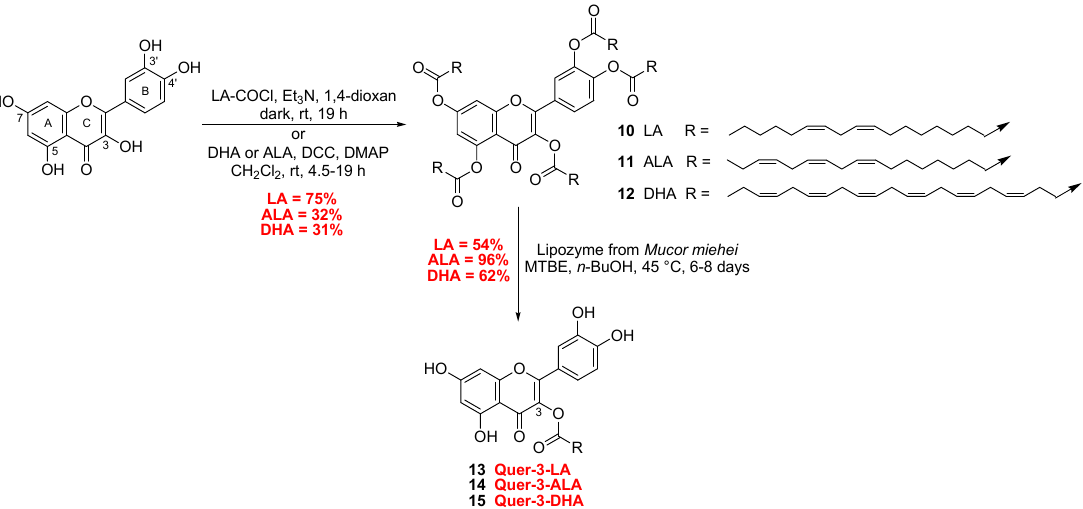
Figure 4. Synthetic pathway to access quercetin-3-LA, 3-ALA and 3-DHA.